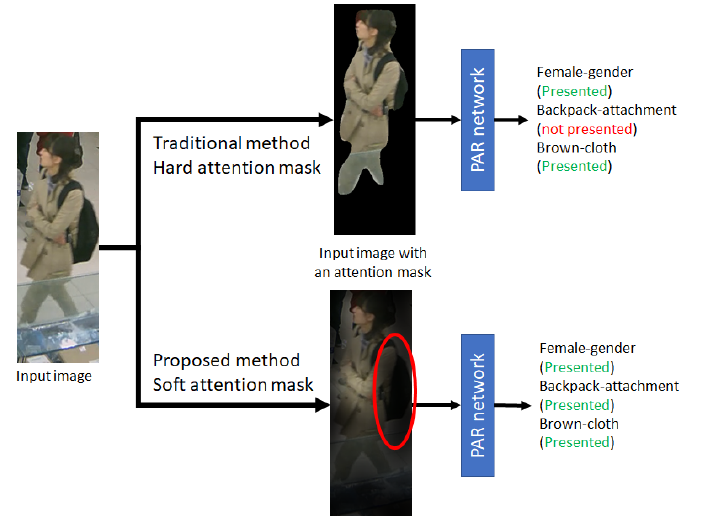
Figure 1. An example of pedestrian image from RAP dataset [9] for PAR network consisting of input image with hard attention mask (Mask-RCNN [7]) and with our soft attention